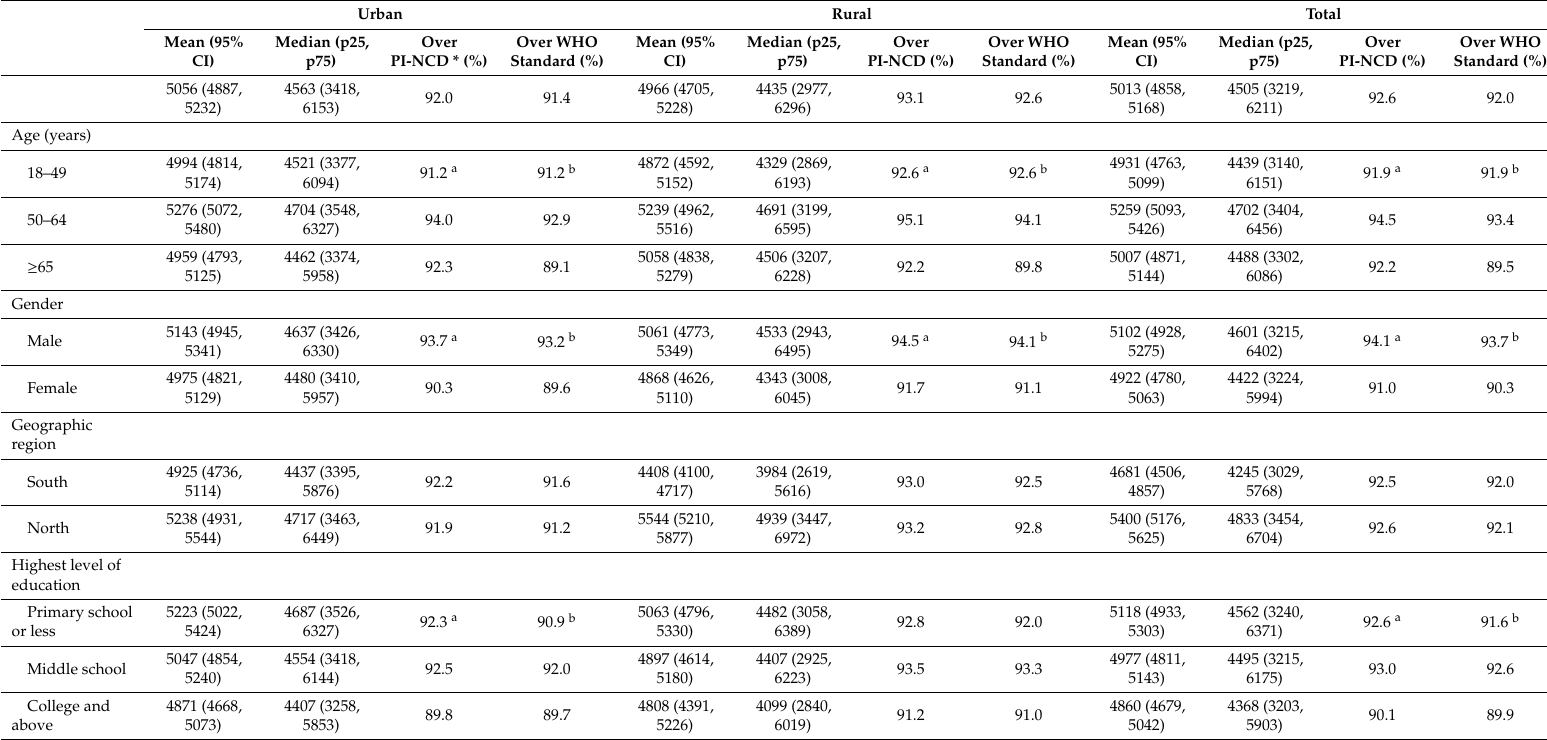
Table 2. Usual dietary intake and the prevalence of excess intake of sodium (mg /